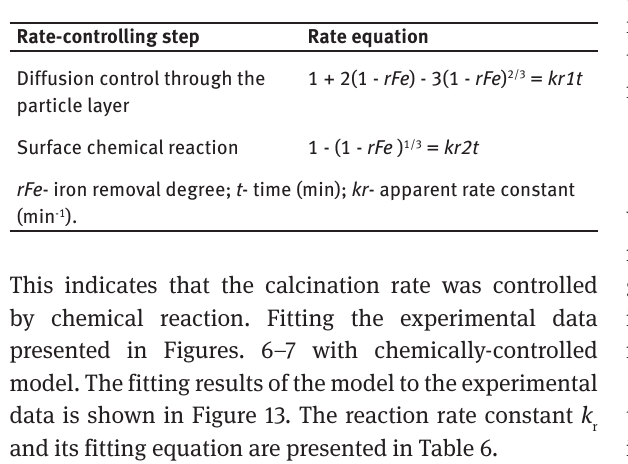
Figure 13. Plots of 1 − (1 − r Fe ) 1/3 vs time for different parameters: (a) ratio of NH 4 Cl to EBFS mass and (b) particle size. Table 5: Integrated rate equations for the shrinking core model. Rate-controlling step Rate equation Diffusion control through the particle layer